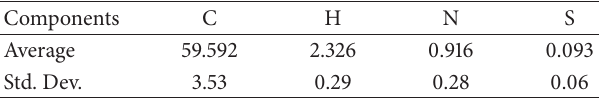
Table4:Ultimateanalysisresultsforcharproducedfromdowndraft gasification of